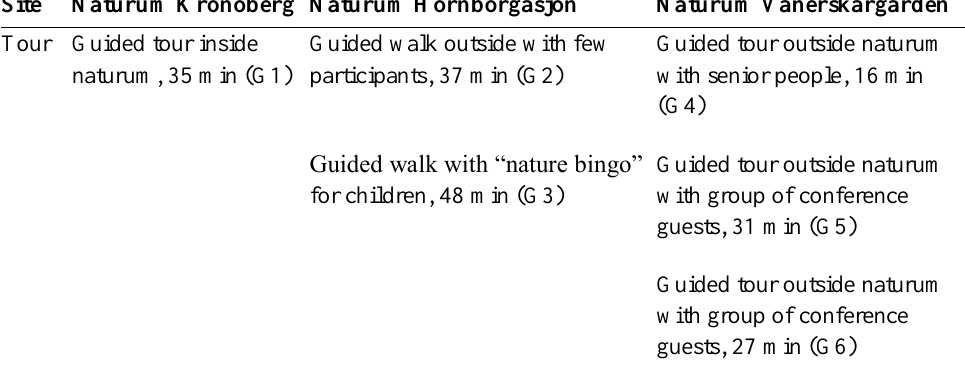
Table 2. Overview of guided tours at the three